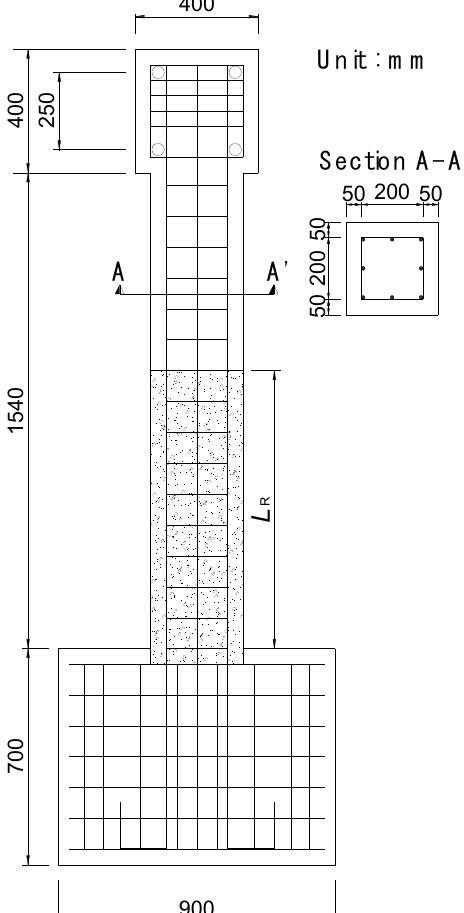
Table 4. Details of column specimens.